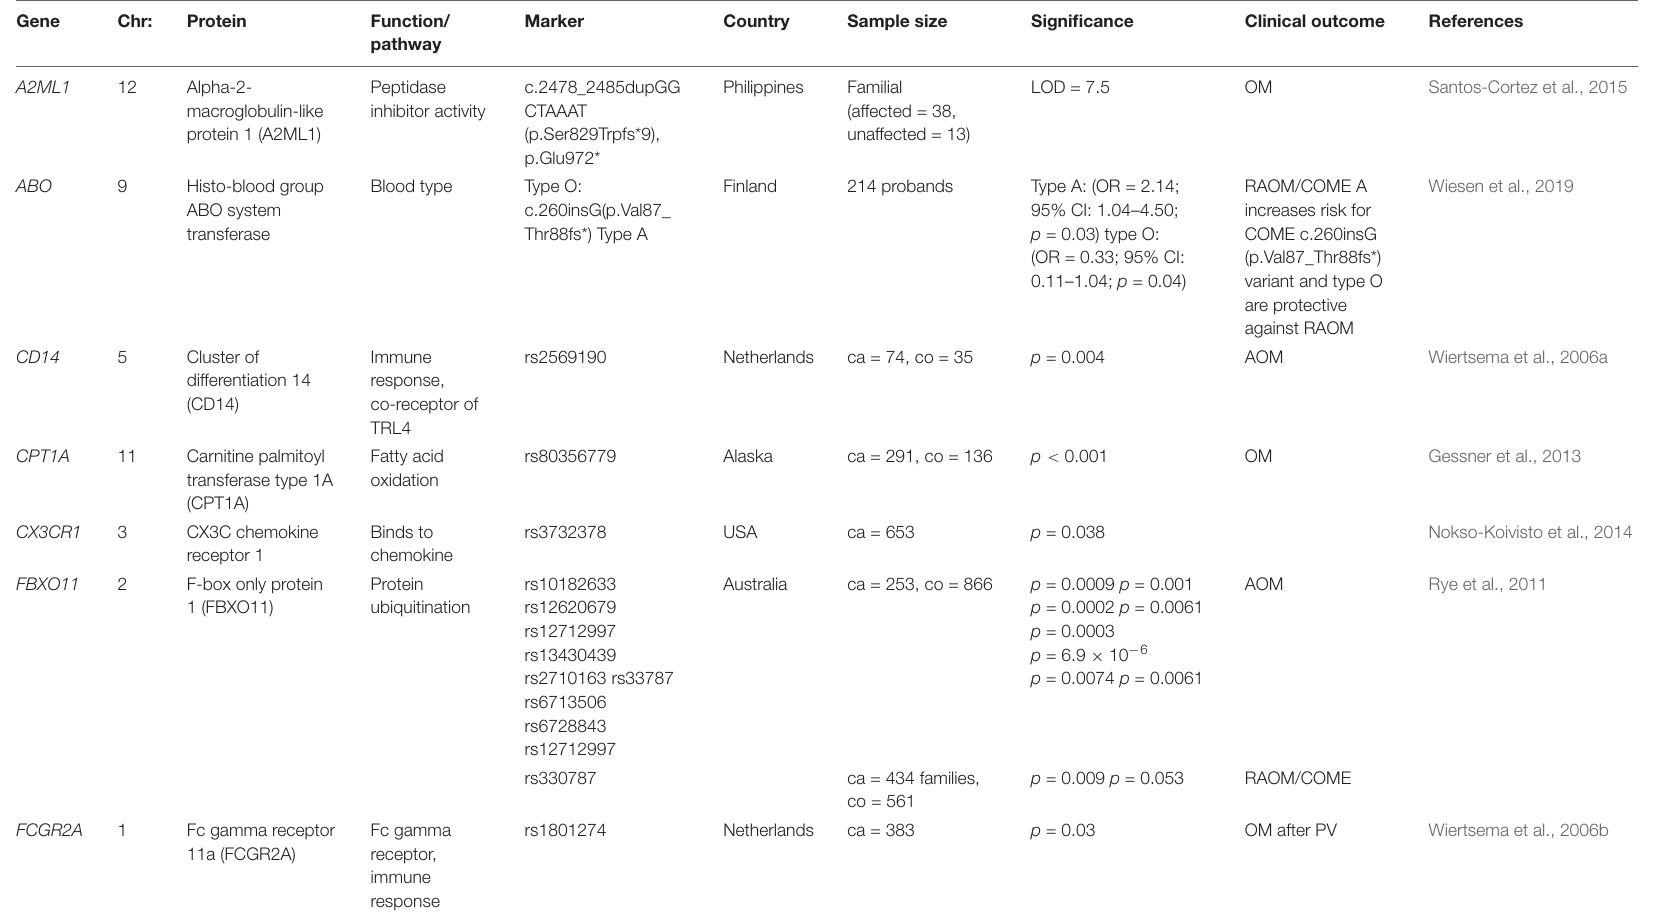
TABLE 2 | Most common loci associated with otitis media in human